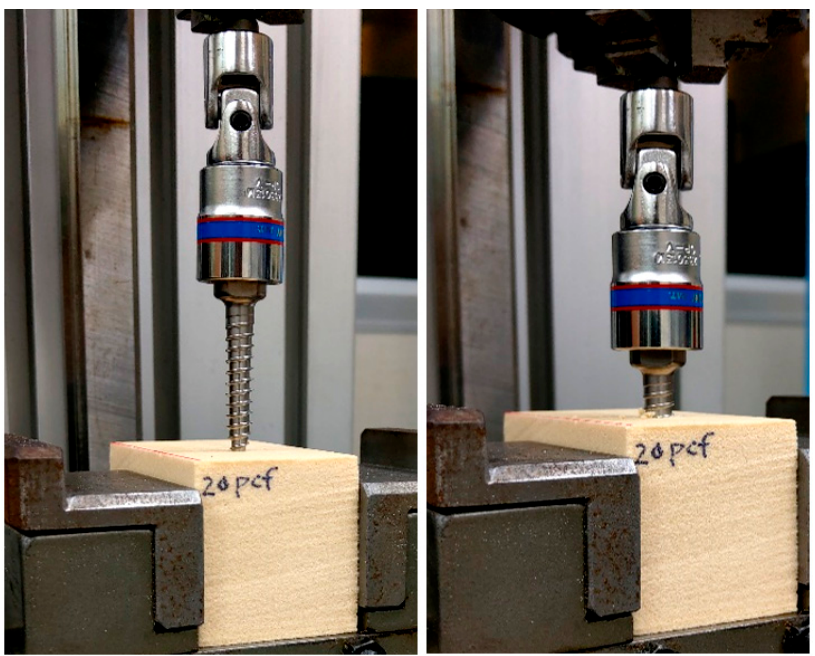
Figure 2. A custom-made pulling jig was used to perform the insertion torque and pullout strength tests.